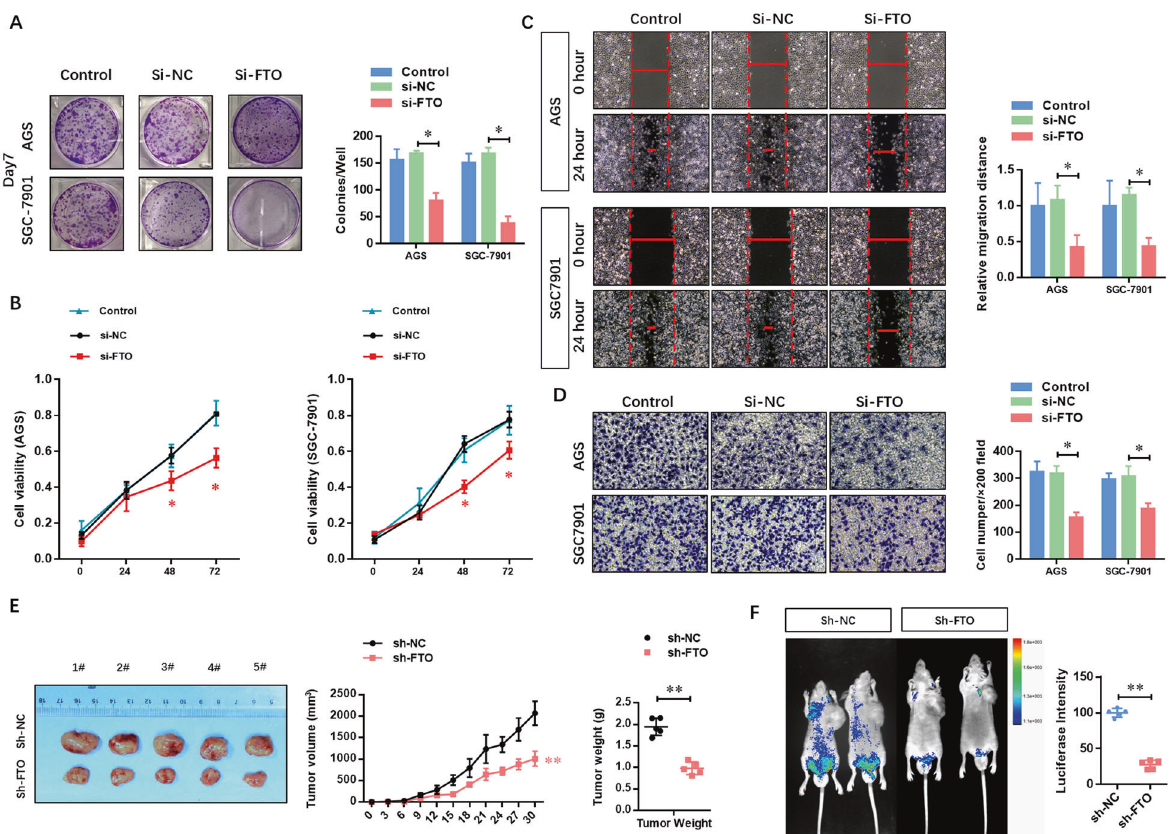
Fig. 3 Depletion of FTO impairs the proliferation and metastasis of GC cells in vitro and in vivo. A The effect of FTO depletion on the colony formation ability of AGS and SGC-7901 cells was analyzed. B The effect of FTO depletion on the cellular viability of AGS and SGC-7901 cells was analyzed by CCK-8 assay. C The effect of FTO deletion on the migration ability of AGS and SGC-7901 cells was analyzed by wound- healing assay. D The effect of FTO depletion on the invasion ability of AGS and SGC-7901 cells was analyzed by transwell assay. E A subcutaneous tumor xenograft in Balb/c nude mice was established to analyze the effect of FTO on the proliferation of GC cells in vivo. F An orthotopic mouse model assay was performed to analyze the effect of FTO on metastasis. N = 3, * p < 0.05, ** p < 0.01 compared with the indicated